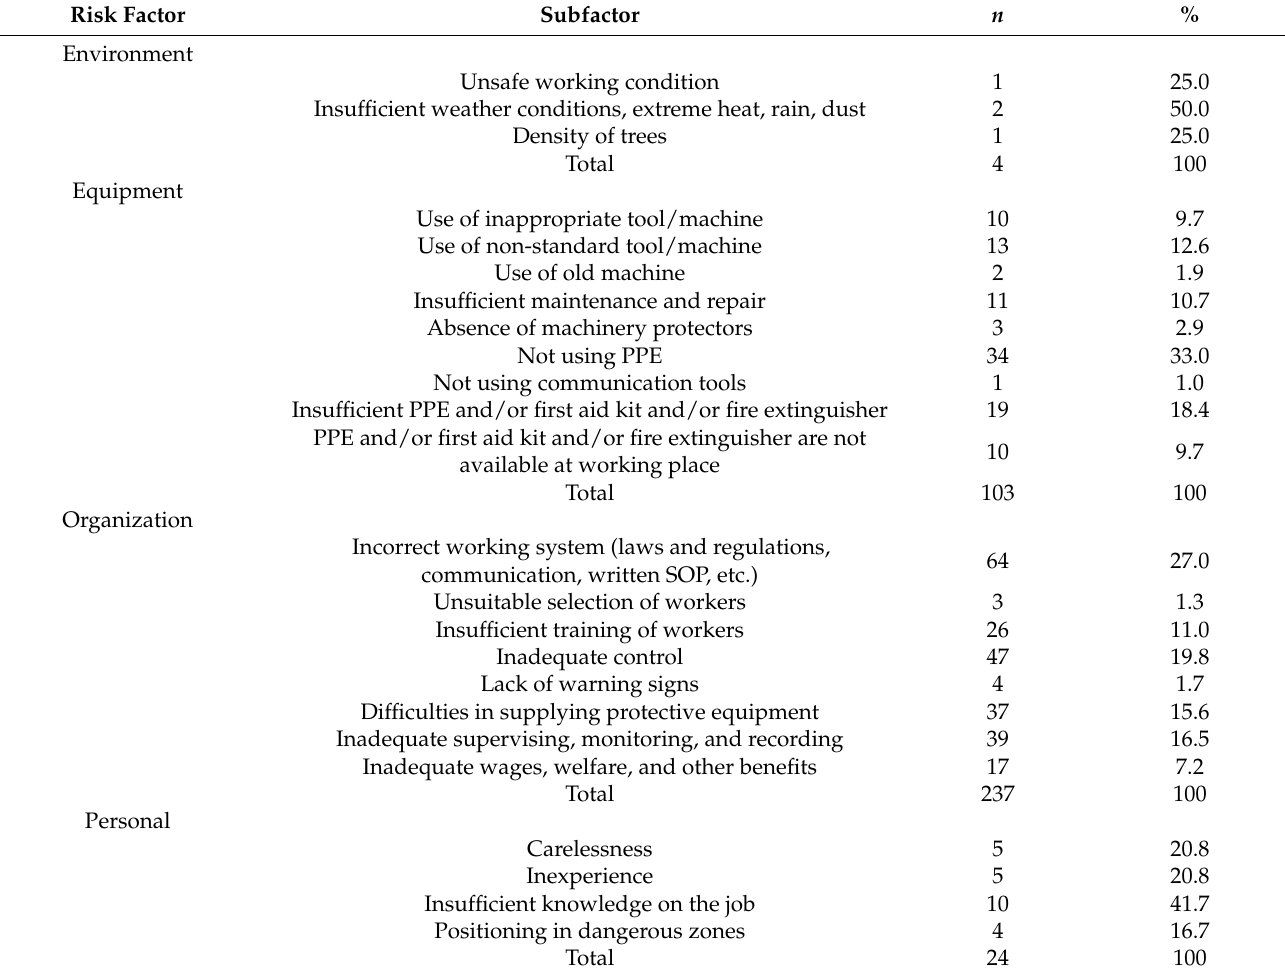
Table 5. Amount ( n ) and share (%) of the major and minor CARs and observations in different risk factor